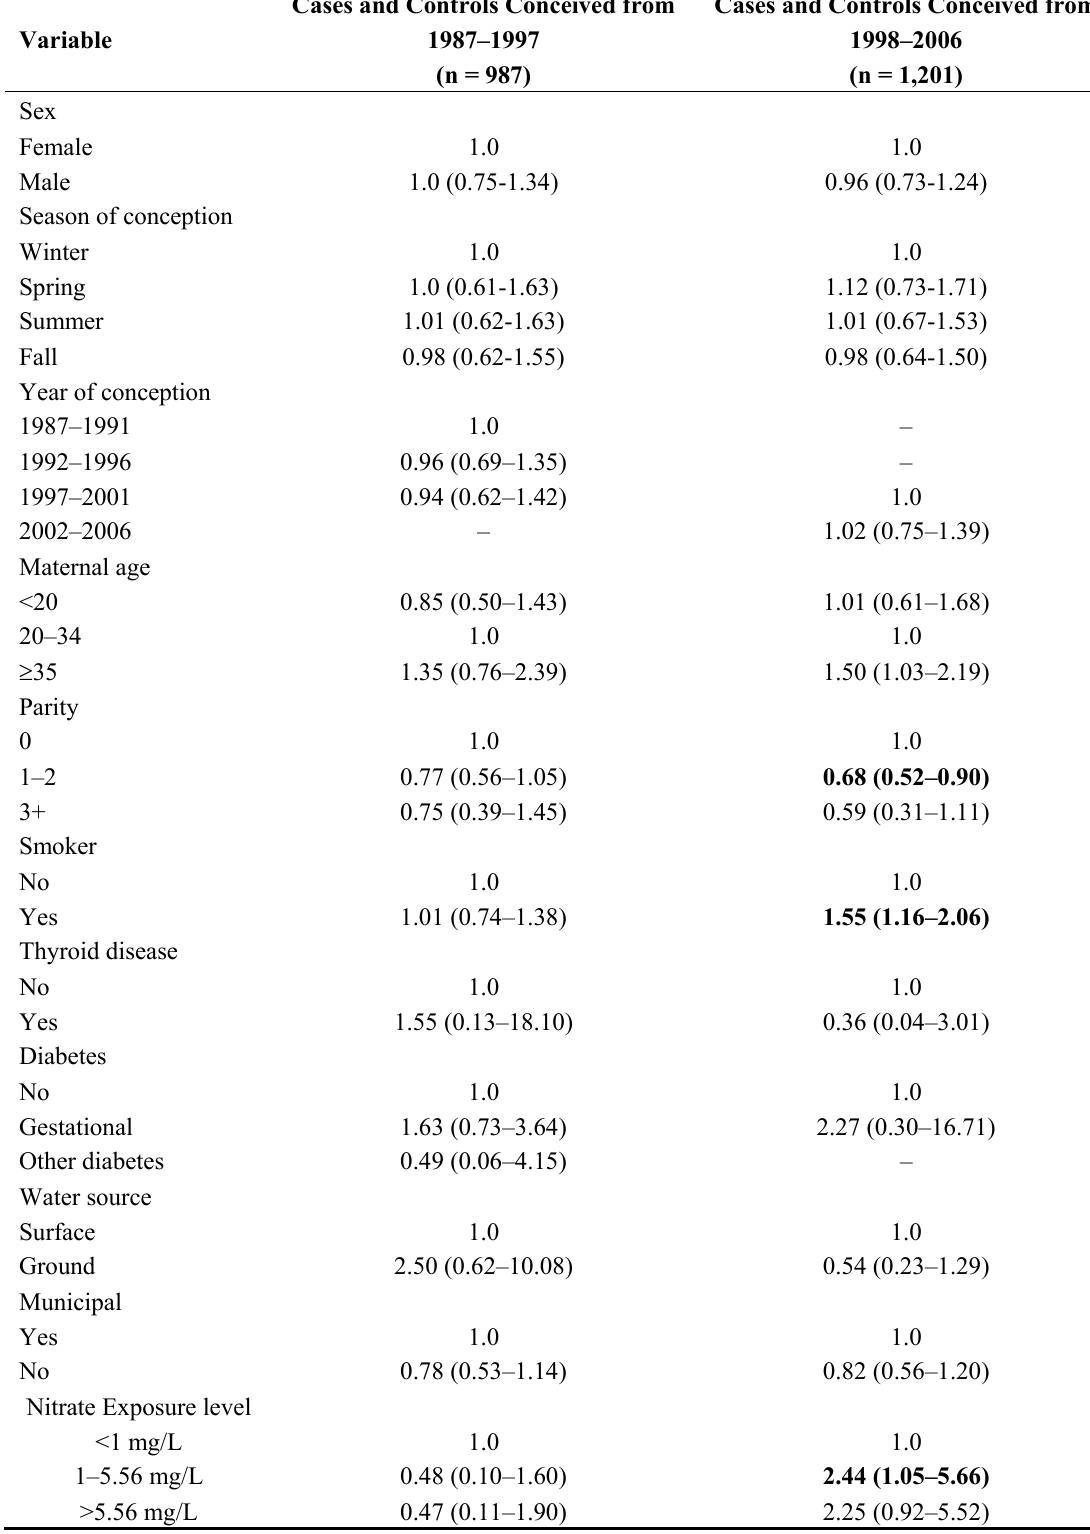
Table 5. Final adjusted multivariate associations between incidence of congenital anomalies and all variables, including nitrate exposure level for cases and controls stratified by date of conception prior to or after 1998, when folic acid fortification was introduced to Nova